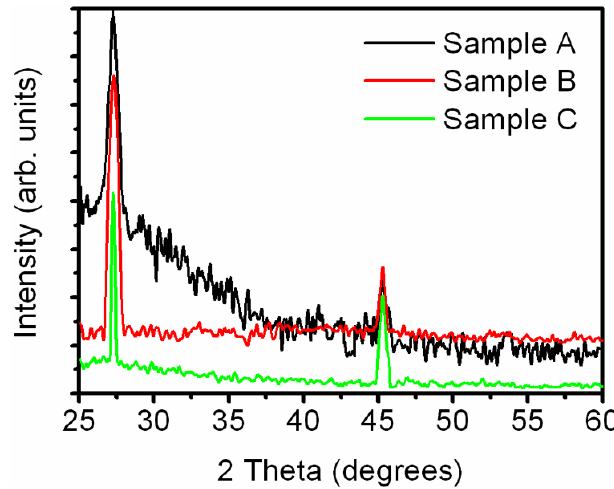
Figure 7. X-ray diffraction (XRD) pattern of as-deposited and rapid thermal annealing (RTA) porous GaAs.